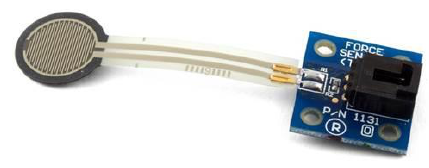
Figure 1. Force sensing resistor ( FSR) sensor.